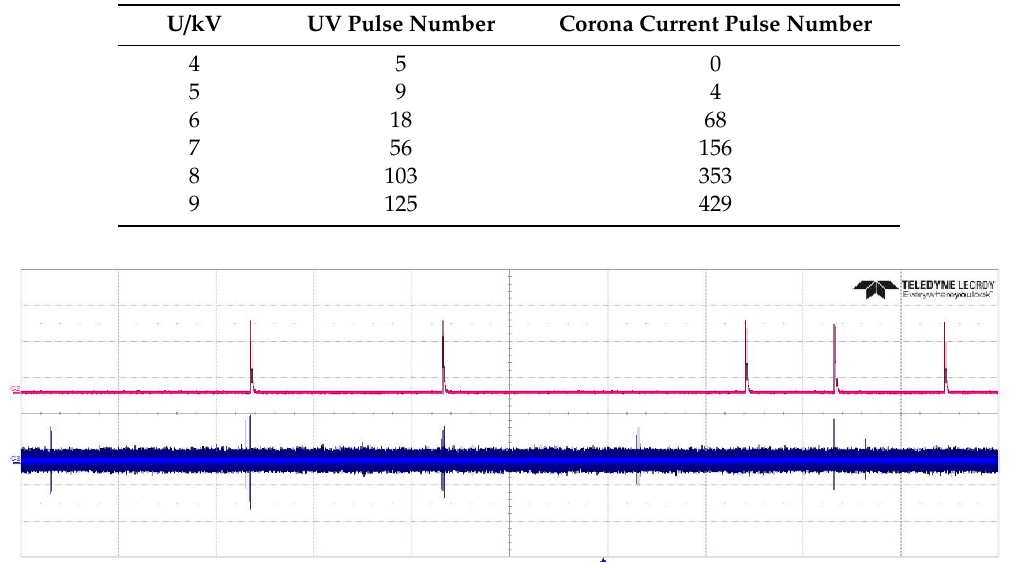
Table 3. Detection pulse number of UV detection and the pulse current method.